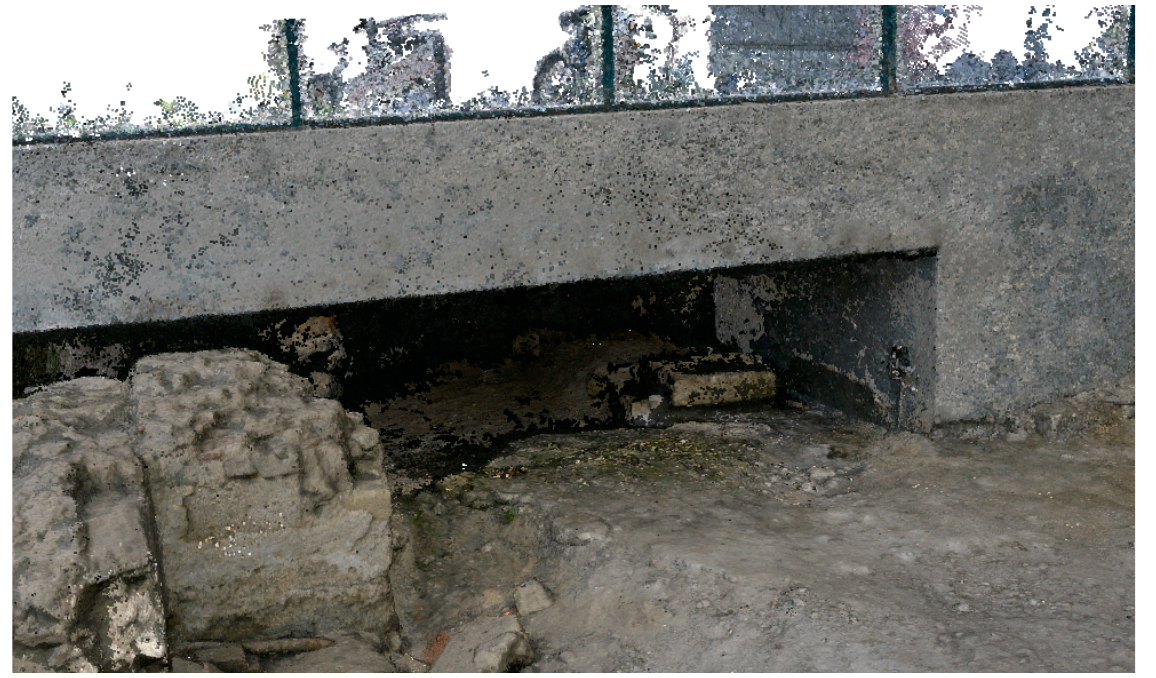
Figure 11. Narrow space with poor light conditions under the terrain of the square—the biggest deviations from TLS were in this area, up to the level of 2 cm.